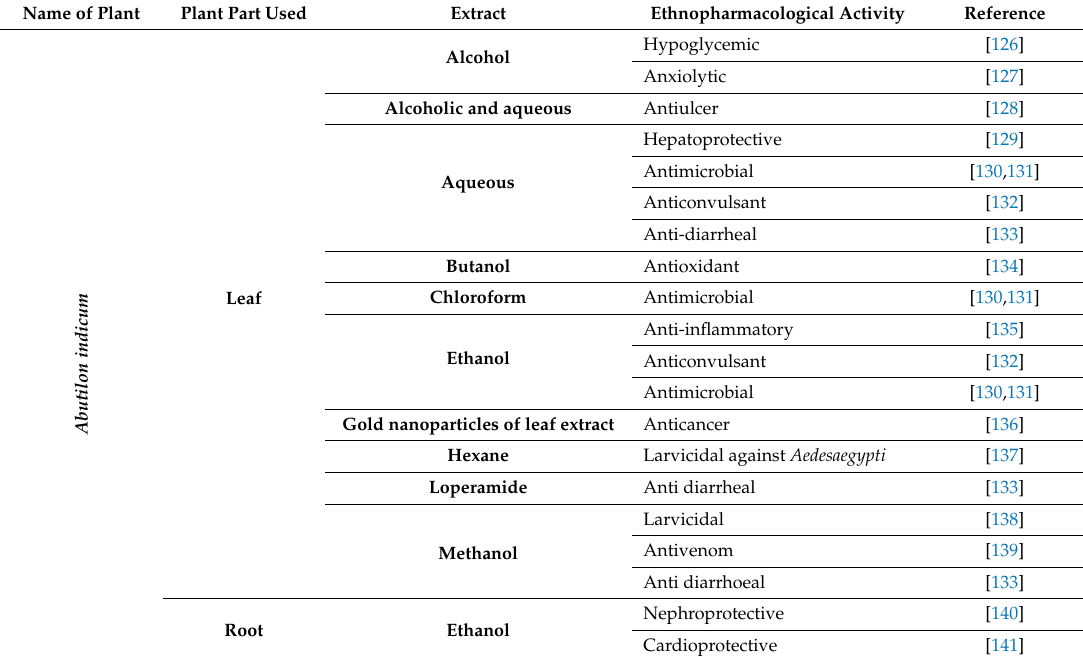
Table 3. Ethnopharmacological activities of the extracts from different parts of Abutilon indicum